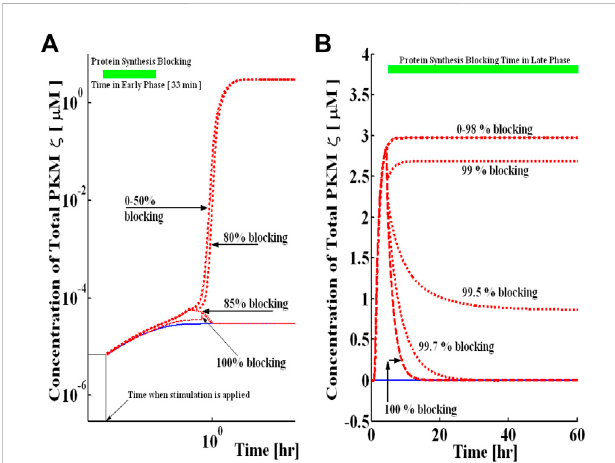
FIGURE 7 Blocking of protein synthesis during the early and late phases in a dose-dependent manner. Simulations are implemented with and without protein synthesis pulse U. A brief pulse of protein synthesis is used to mimic theinductionof L-LTP by applying ahigh-frequency stimulus. The solid blue line represents the PKM ζ concentration at basal levels of protein synthesis (without the application of pulse), and the dashed red line represents the PKM ζ concentration with the application of a protein synthesis pulse. (A) Protein synthesis blocking during induction for 33 min (solid green line shows blocking time). For different levels of blocking, L-LTP has a different outcome during the maintenance phase. (B) Protein synthesis blocking during maintenance for 44 h (solid green line shows blocking time). Even for a very high percentage of blocking, the upregulated state can still be maintained, suggesting that if PKM ζ is a trace for long-term memories, its expression can still be observed even if the synthesis of new proteins is